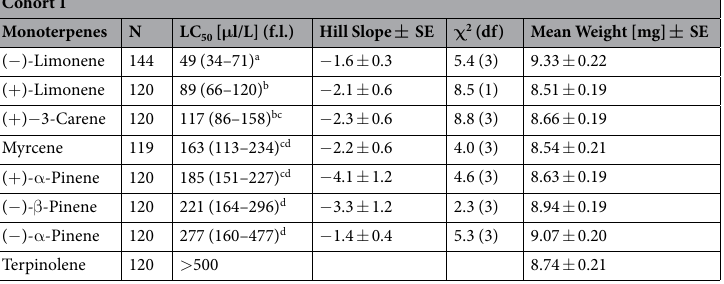
Table 1. Toxicity of monoterpene volatiles against MPB from cohort 1. Dose-response models of the logit- transformed mortality data were used to determine the LC 50 values, 95% fiducial limits (f.l.), and Hill slope for each monoterpene tested. LC 50 values denoted with the same letter were not significantly different. Multiple comparisons between LC 50 values were conducted via pairwise t-tests on the log (LC 50 ) values of the Hill equation, using a pooled standard error, and correcting for experiment-wise error by the Benjamini–Hochberg procedure. The goodness-of-fit test χ 2 (degree of freedom) was used to assess the fit of the dose-response model. Less than 50% of the beetles died at all doses of terpinolene. The mean weight of the beetles tested for each compound in cohort 2 was not significantly different and the mean weight of the beetles tested with a given monoterpene was the same at all doses (ANOVA, p-value = not significant). As sex was not a significant factor in mortality for all monoterpenes tested, the data for both sexes was